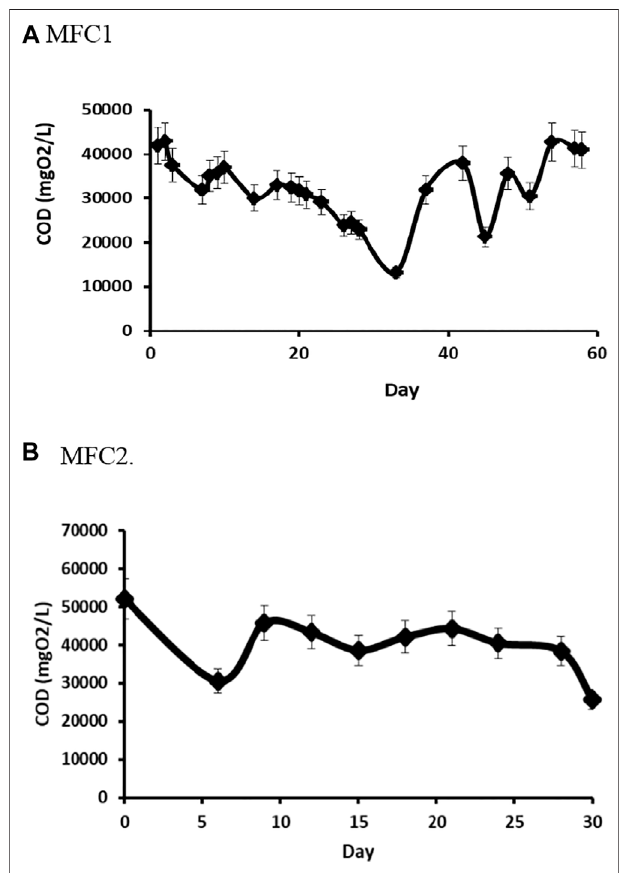
FIGURE 6 | Changes in COD during operation of MFCs. Anode chambers were replenished daily with fresh medium to compensate for decrease in liquid volume. The COD measured is the difference between the amount fed and the amount consumed. (A) MFC1 (B) MFC2